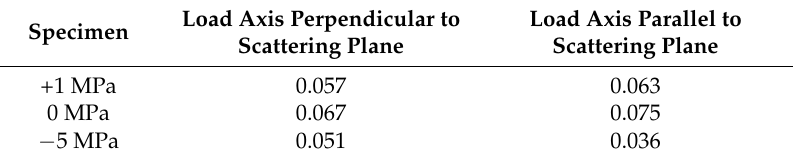
Table 2. Normalized global refraction value C m / µ as a function of orientation of the load axis of the investigated specimens to the scattering plane of the analyzer crystal. Relative error bars lie around 1–2%. Note that cracks perpendicular to the load axis are visible if the scattering plane is parallel to the load axis and